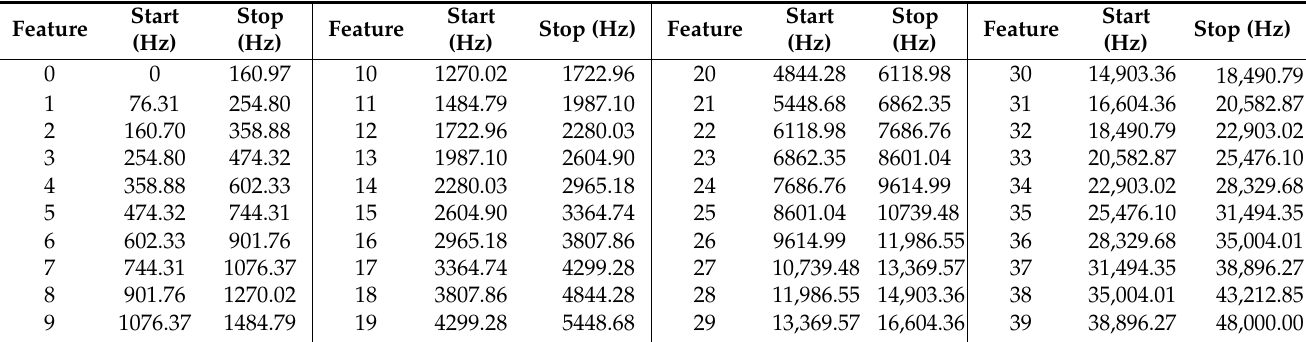
Table 3. Start/Stop frequencies for Mel triangular filters given a sample rate of 96k and 40 Mel